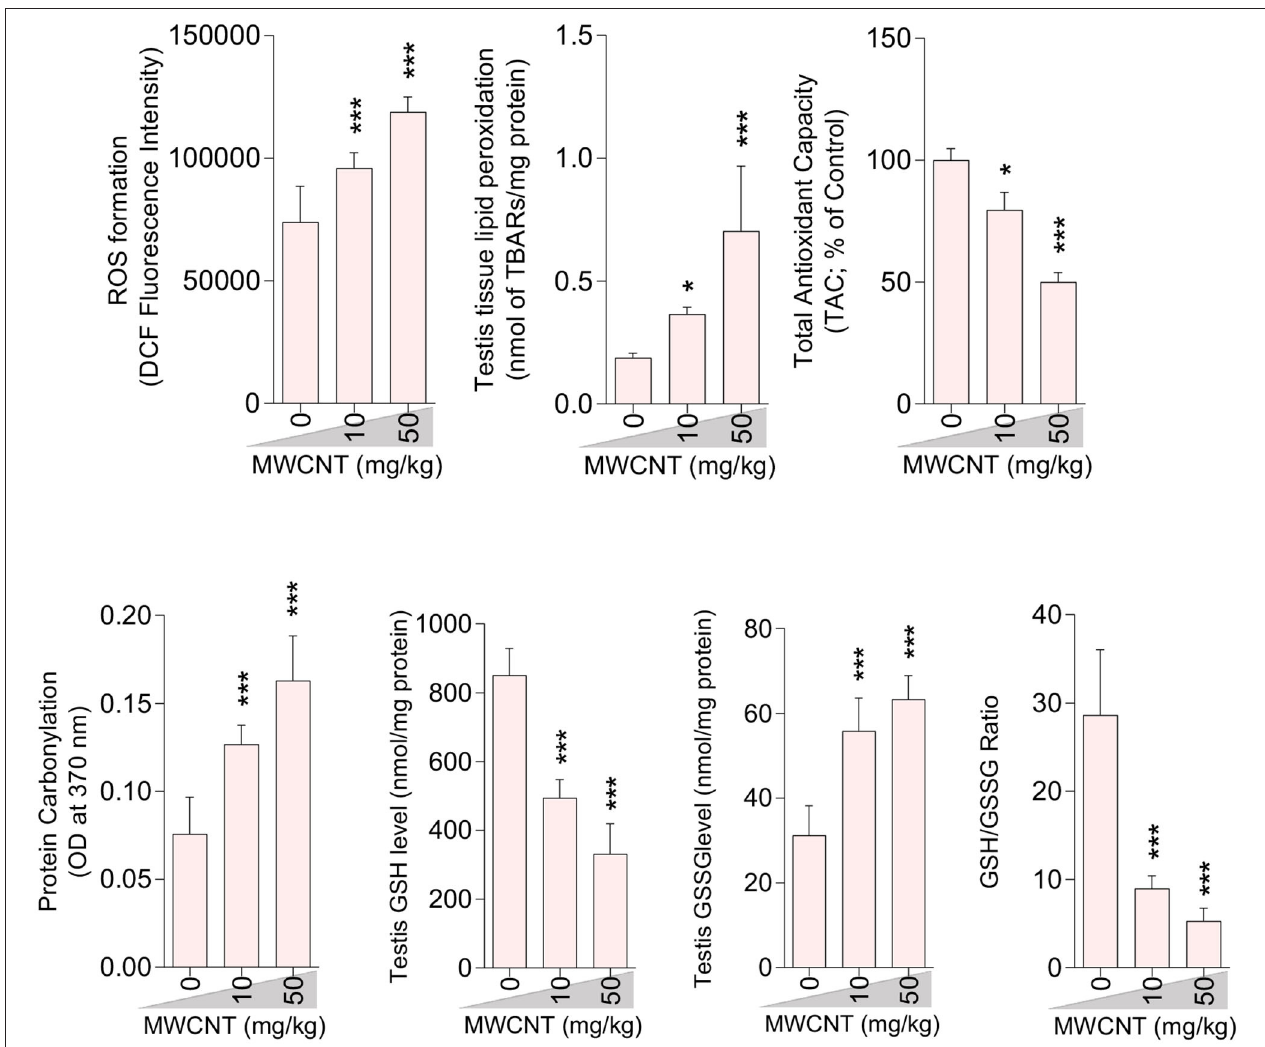
FIGURE 6 | Effect of multi-walled carbon nanotubes (MWCNT) on oxidative stress parameters in the testis tissue of mice (mean ± SEM, n = 6). Asterisks indicate significantly different from the control (0 ppm) group (* P < 0.05, *** P < 0.001).